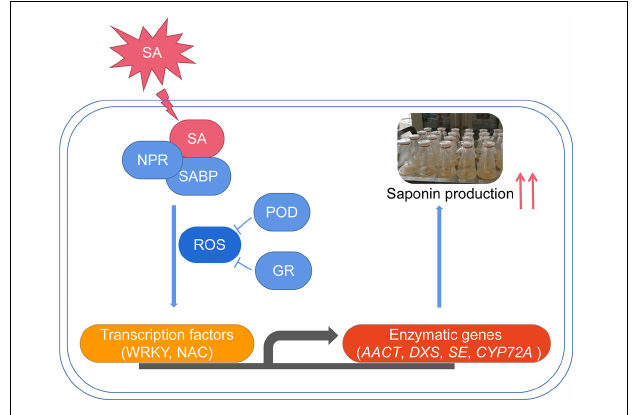
FIGURE 10 | The proposed transcriptional regulatory network for SA-elicited saponin biosynthesis in P. tunicoides hairy root